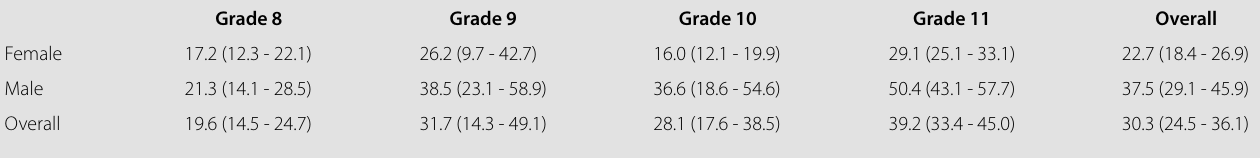
Table 3. Proportion of participants (% (95% CI)) with a CRAFFT score of 2 or more, by grade and gender ( N